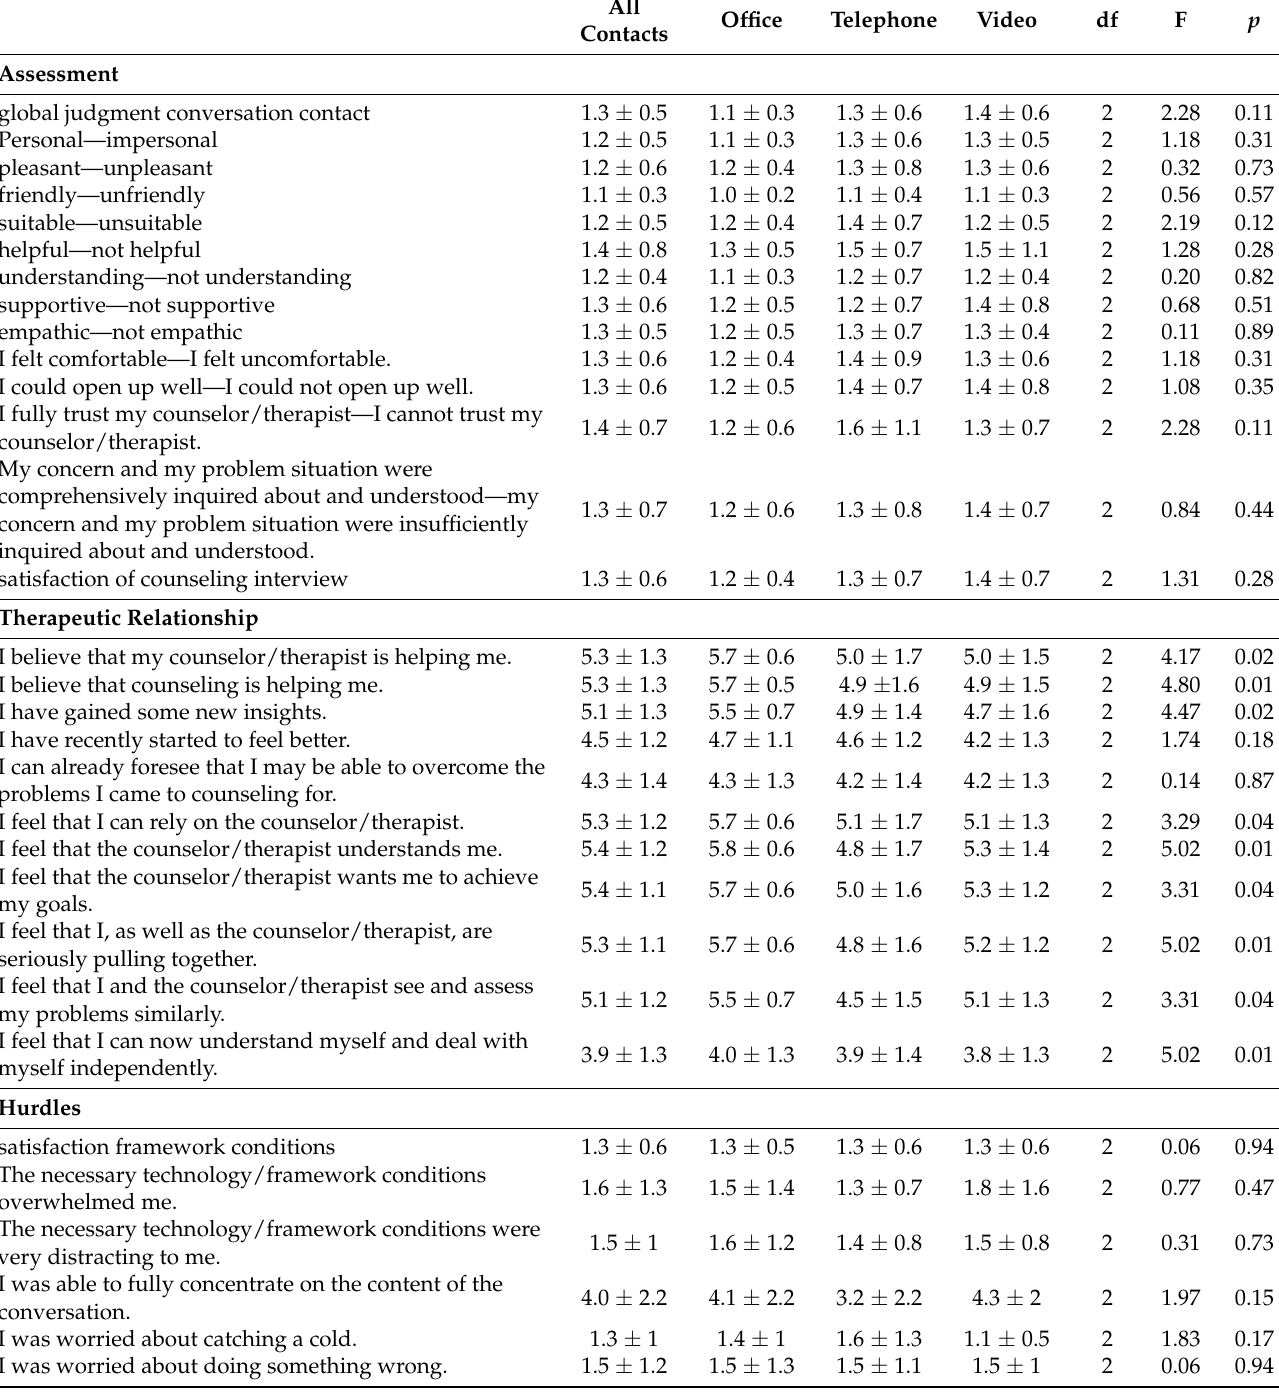
Table 2. Assessment of therapeutic contact, therapeutic relationship, and hurdles in different counseling formats.